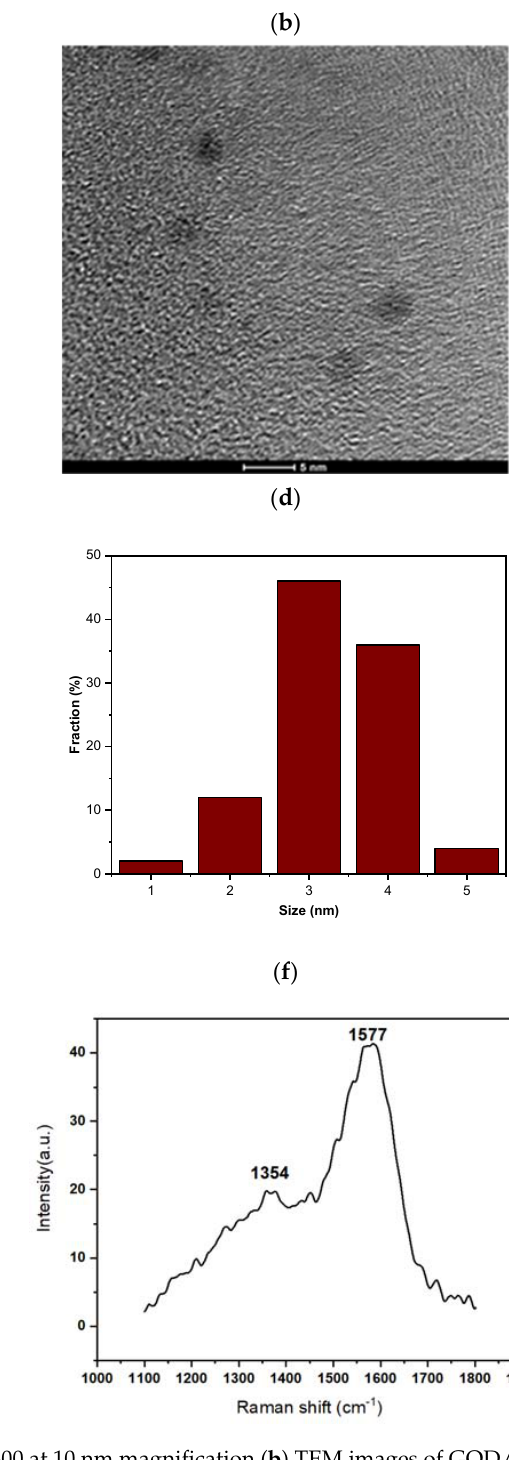
Figure 4. ( a ) TEM images of GQD/300 at 10 nm magnification ( b ) TEM images of GQD/300 at 5 nm magnification ( c ) particle size distribution of GQD/300 ( d ) XRD spectrum of GQD/300 ( e ) FTIR spectrum of GQD/300 ( f ) Raman spectrum of GQD/300.